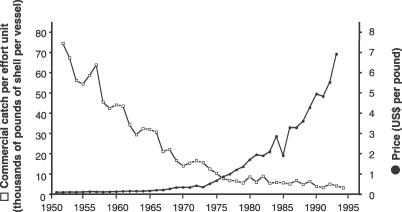
California Commercial White Abalone Haliotis sorenseni Landings for 1972–1992The price exponentially increased as catch decreased. The catch takes the fishing effort into account, so that decreased catch does not come from a diminishing effort. Results are given as weight in shell divided by the number of ships (open squares) and price (filled circles) [27].